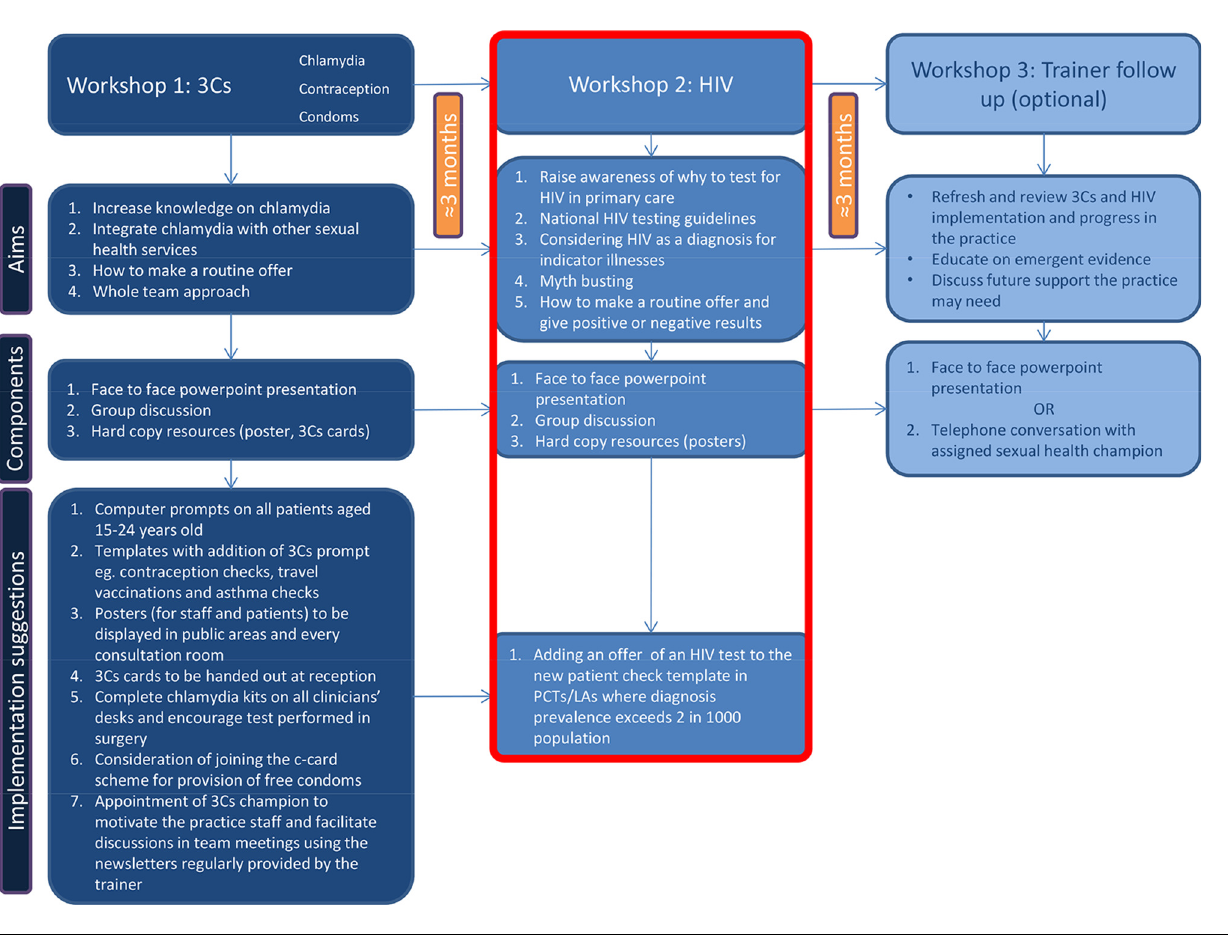
Figure 1. The 3Cs (chlamydia, contraception, condoms) and HIV (human immunodeficiency virus) intervention with the components that aim to increase HIV testing highlighted in